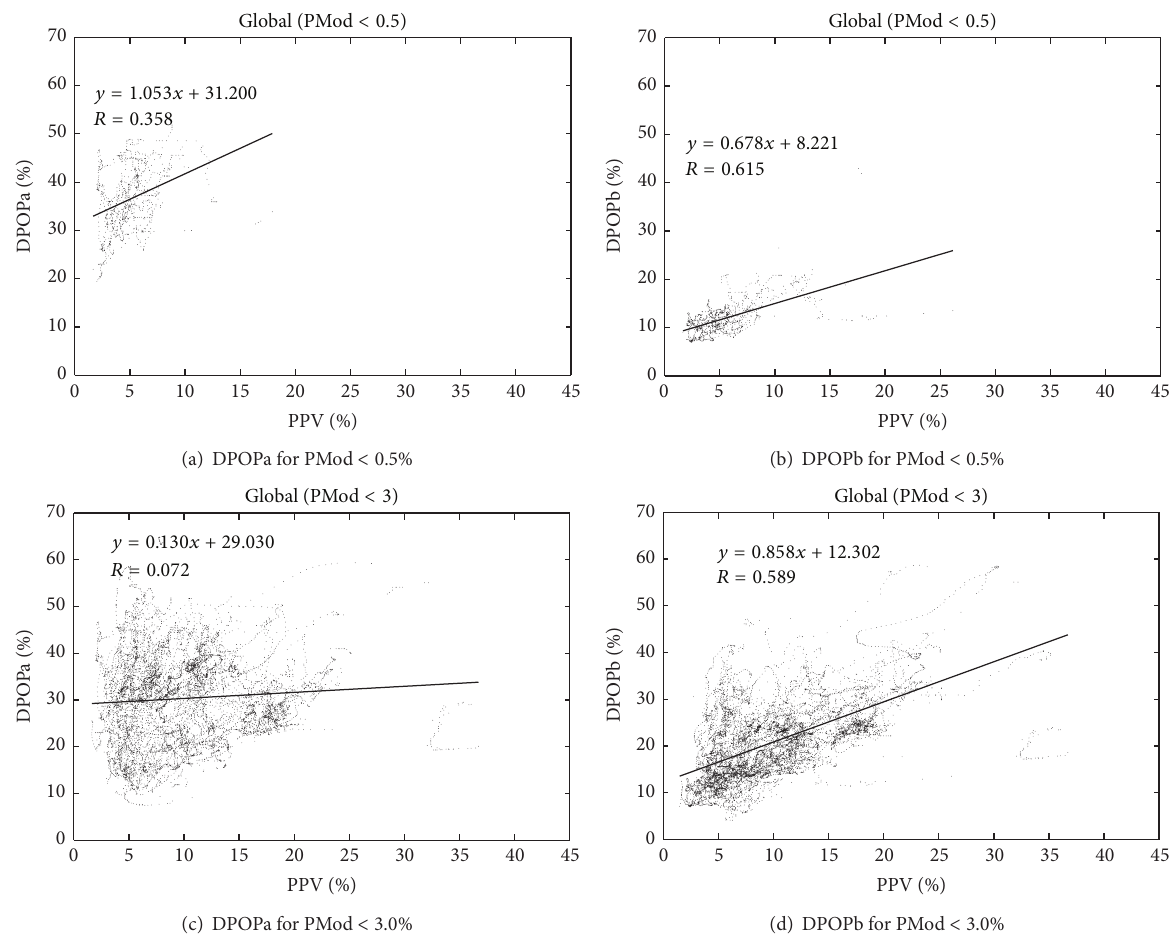
Figure 6: DPOP results for low PMod